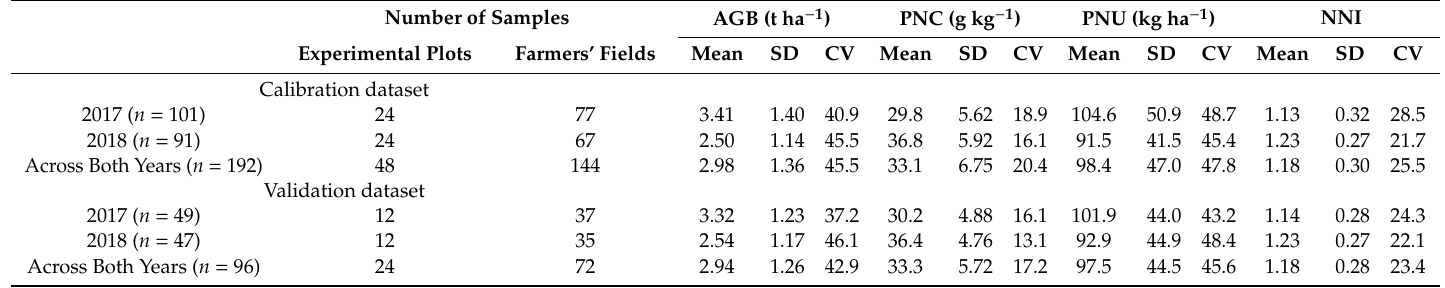
Table 1. Descriptive statistics of winter wheat aboveground biomass (AGB), plant nitrogen concentration (PNC), plant nitrogen uptake (PNU), and nitrogen nutrition index (NNI) for calibration and validation datasets across varieties and